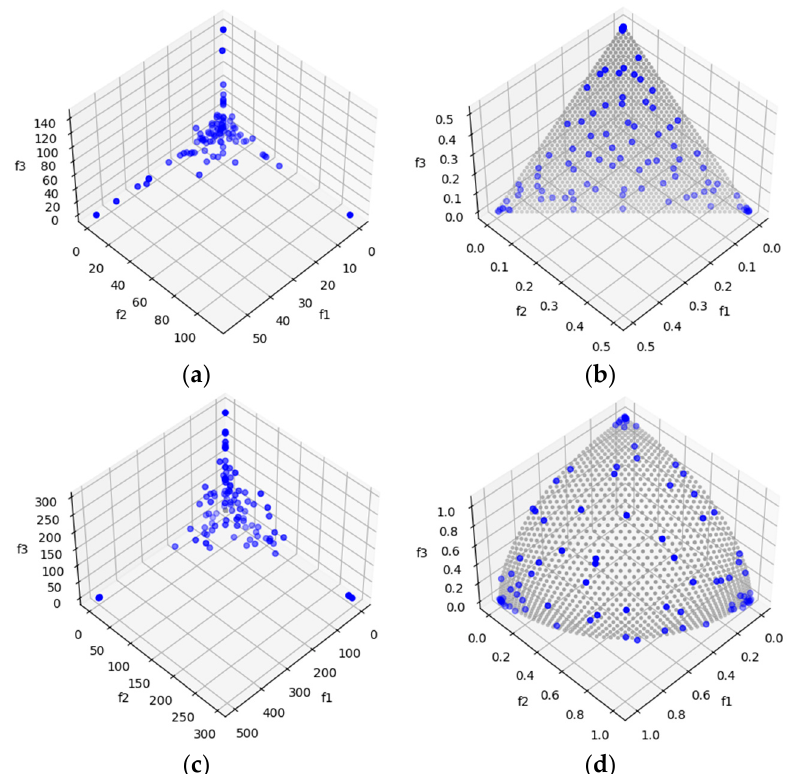
Figure 3. The plots of the approximate PFs with the highest HV value against real PF. ( a ) DTLZ1 approximate PF using MOSA/D-CGO; ( b ) DTLZ1 approximate PF using MOSA/D-DE; ( c ) DTLZ3 approximate PF using MOSA/D-CGO; ( d ) DTLZ3 approximate PF using MOSA/D-DE.